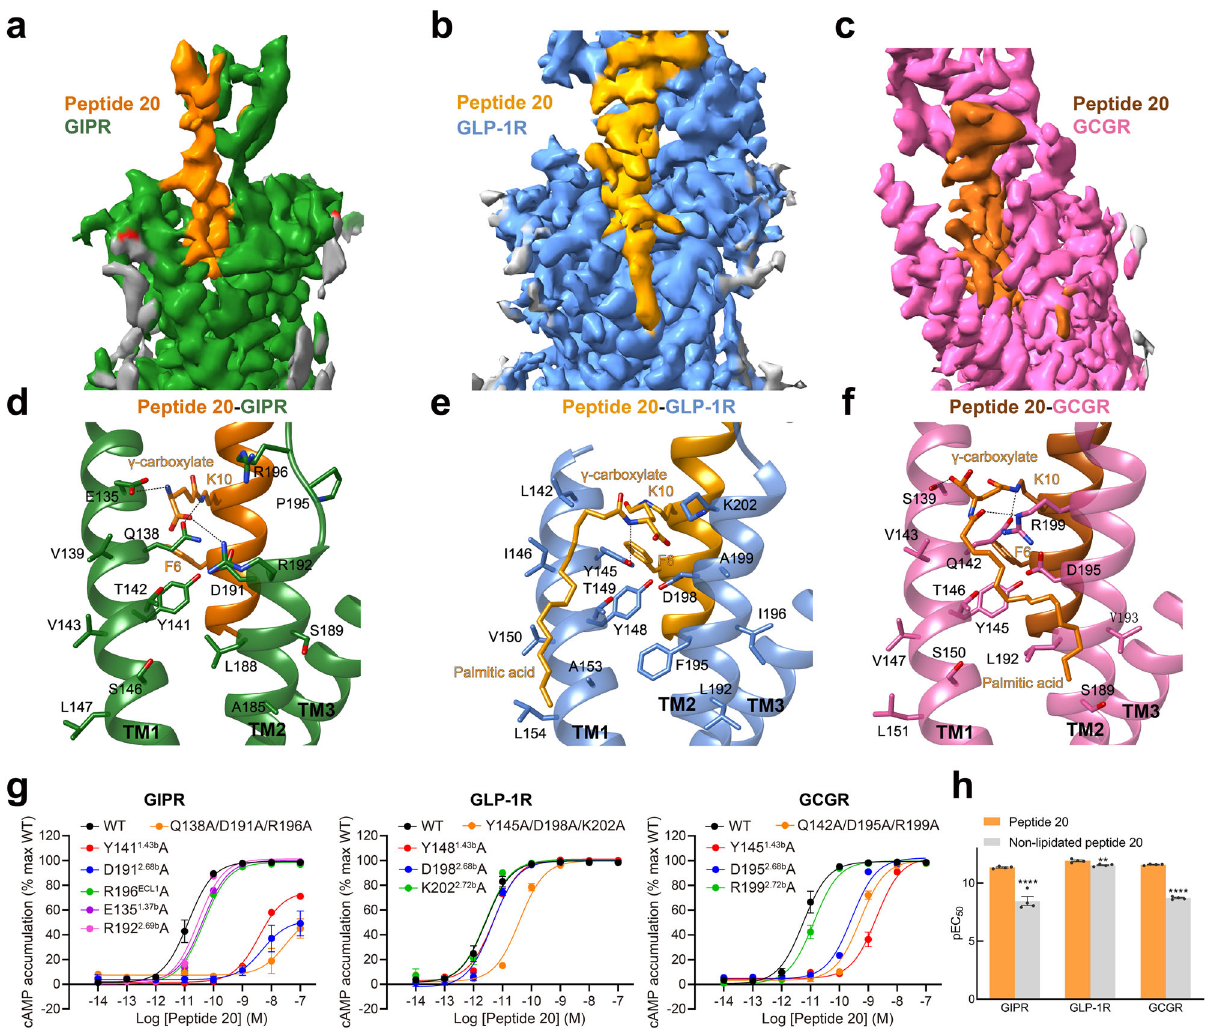
Fig. 5 Structural and functional feature of lipidated K10 P of peptide 20. a – c Close-up views of the crevices between TM1 and TM2 displayed by cryo-EM maps of peptide 20-bound GIPR a , GLP-1R b , and GCGR c . Continuous electron densities connected to K10 in peptide 20 were observed in the three peptide 20-bound receptor – G s complexes. d – f Interactions between lipidated K10 P and the TM1-TM2 crevice of GIPR d , GLP-1R e , and GCGR f , with interacting residues shown in sticks. Hydrogen bonds are shown with dashed lines. g Effects of receptor mutations on peptide 20-induced cAMP accumulation. Data shown are means ± S.E.M. of at least three independent experiments ( n = 3 – 9) performed in quadruplicate. h Effects of K10 lipidation on peptide 20-induced cAMP accumulation. The bar graph represents the average pEC 50 (that is, − logEC 50 ) and data are presented as means ± S.E.M. of four independent experiments ( n = 4) performed in quadruplicate. Statistically signi fi cant differences were determined with a two-tailed Student ’ s t test. ** P < 0.01 and **** P < 0.0001. WT, wild-type. Source data are provided as a Source Data fi